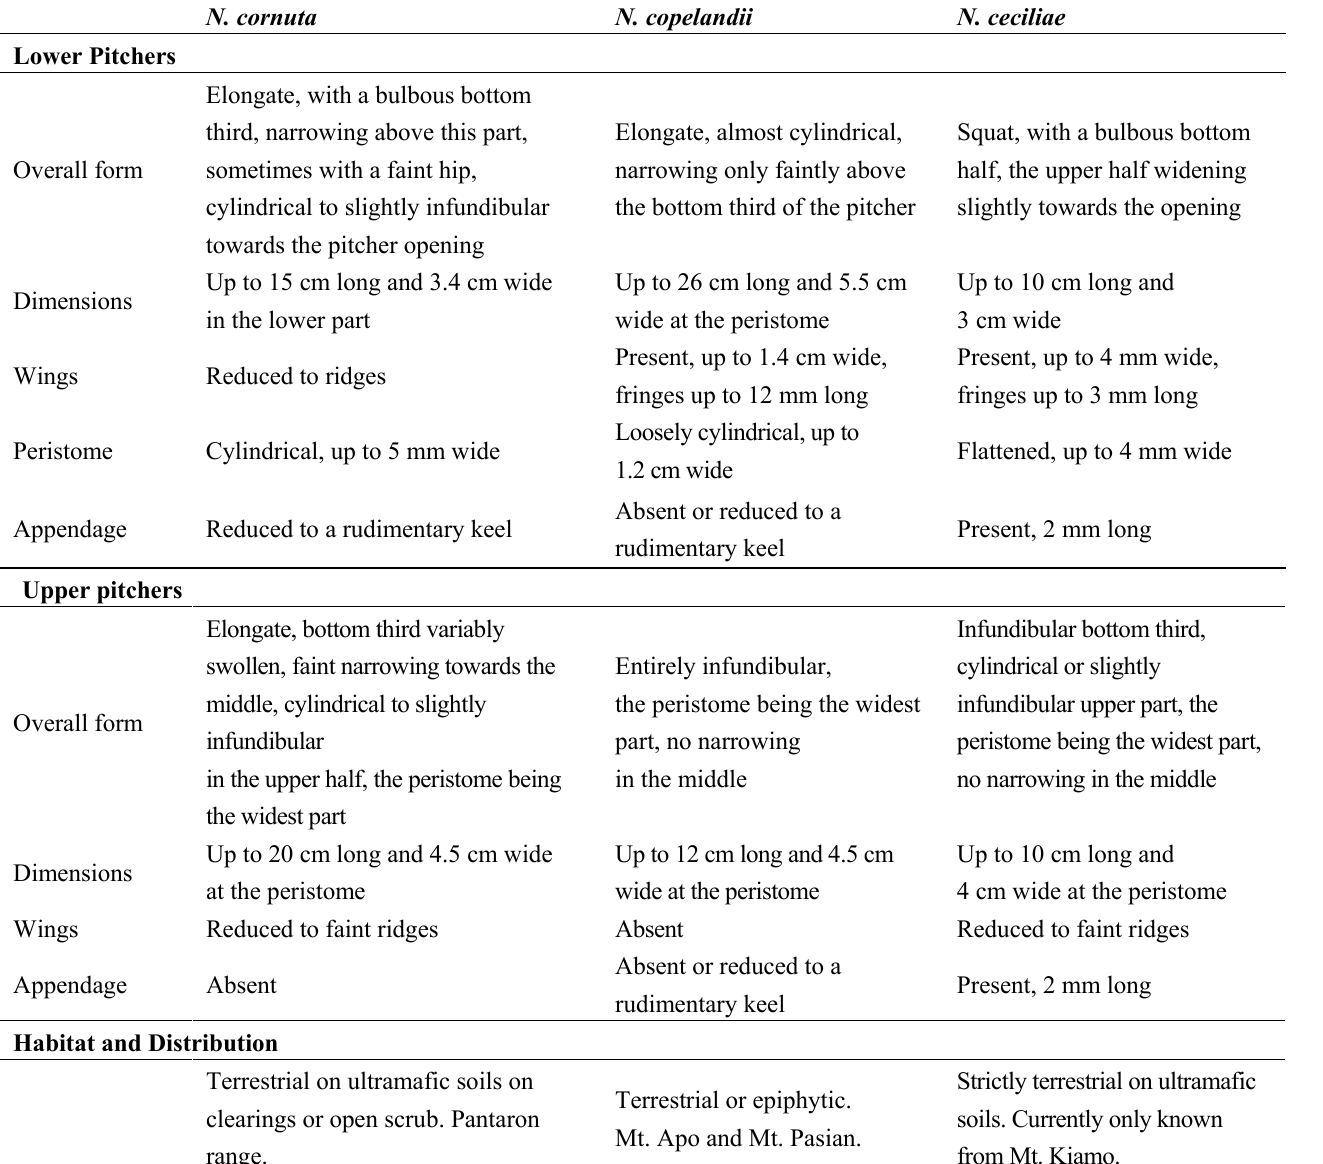
Table 2. The main morphological differences between N. cornuta , N. copelandii and N. ceciliae (data from